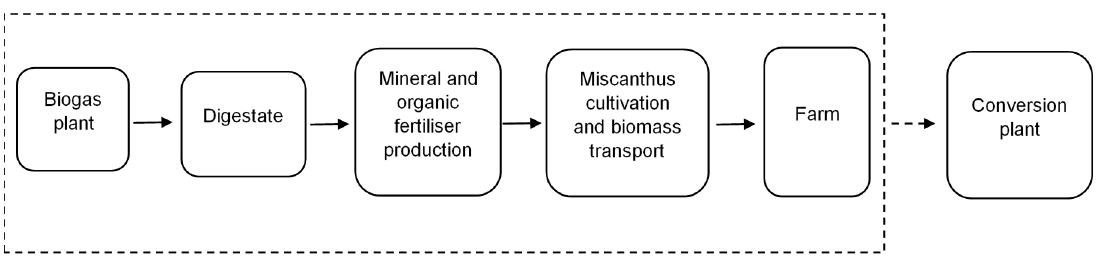
Figure 1. System boundaries for the cultivation, harvest, and transport of miscanthus.